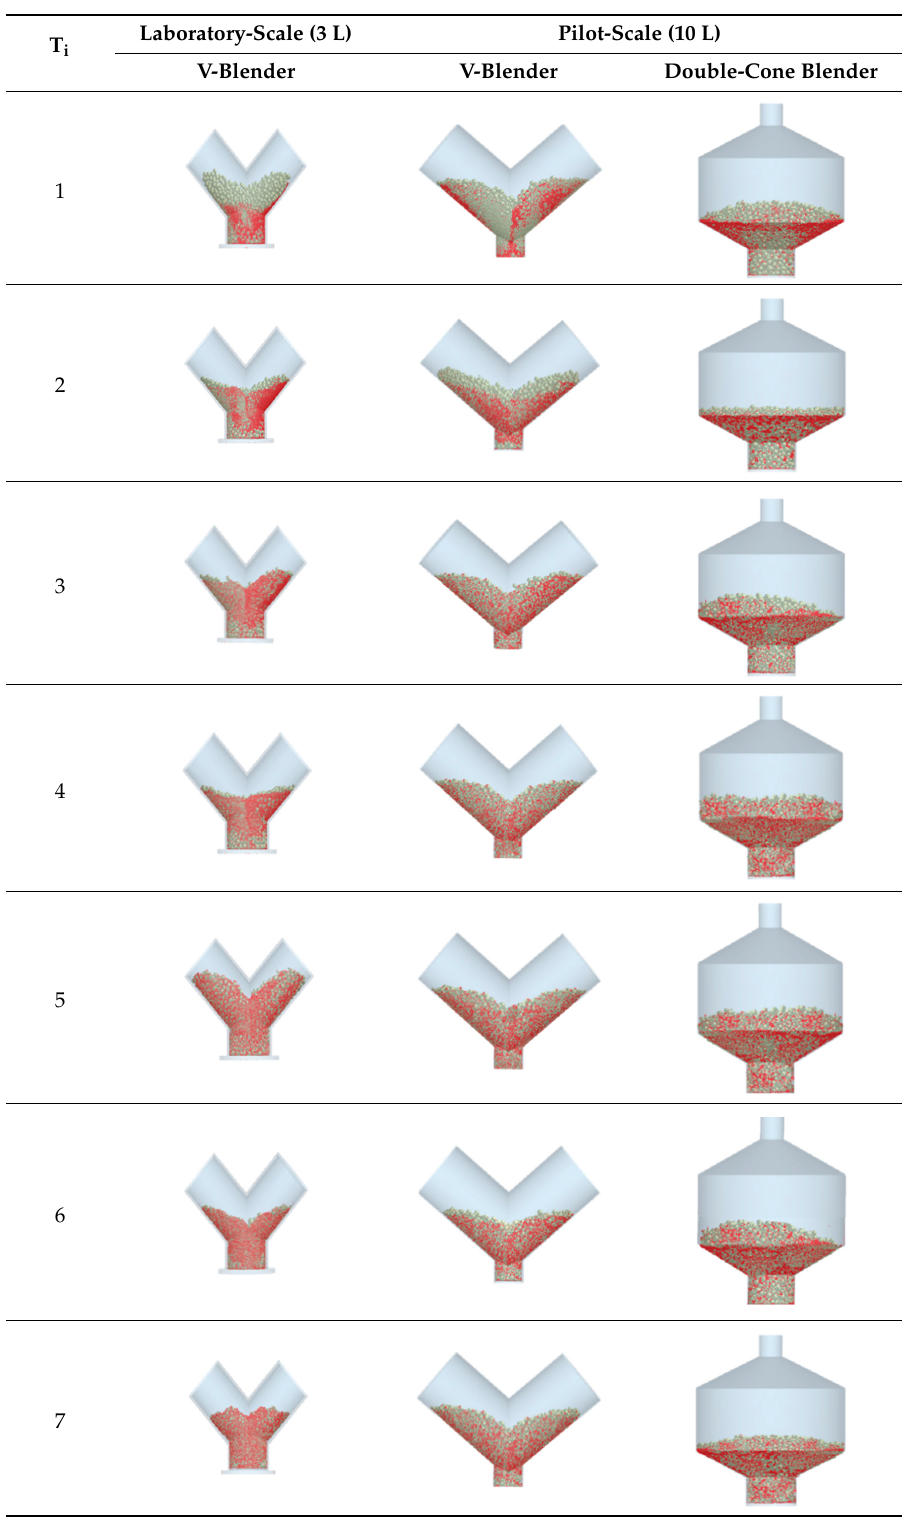
Table 8. Snapshots of blending simulation at each scale according to T i value. Amlodipine besylate particles are marked in red and other particles of each material are marked in